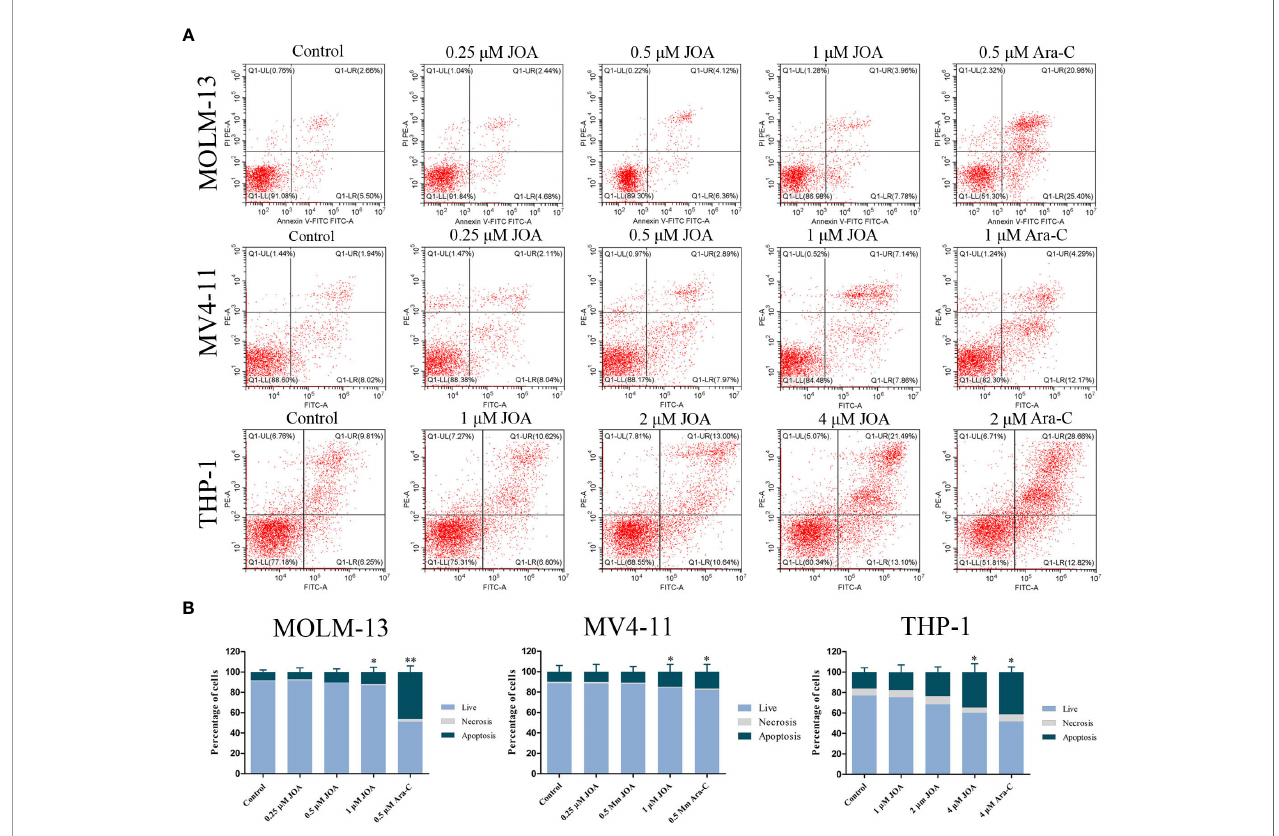
FIGURE 4 | JOA does not induce signi fi cant apoptosis in MV4-11, MOLM-13 and THP-1 cells. (A) Cells were treated with JOA or Ara-C for 72 h and cell apoptosis was determined by fl ow cytometric analysis. (B) Graph bars show the percentage of living cells and cells undergoing necrosis/apoptosis. MOLM-13, MV4-11 cells were treated with 0.25, 0.5, 1 m M JOA or Ara-C (0.5 or 1 m M) and THP-1 were treated with 1, 2, 4 m M JOA or 4 m M Ara-c for 72h. (*p < 0.05, **p < 0.01). The cell apoptosis analysis was performed for four